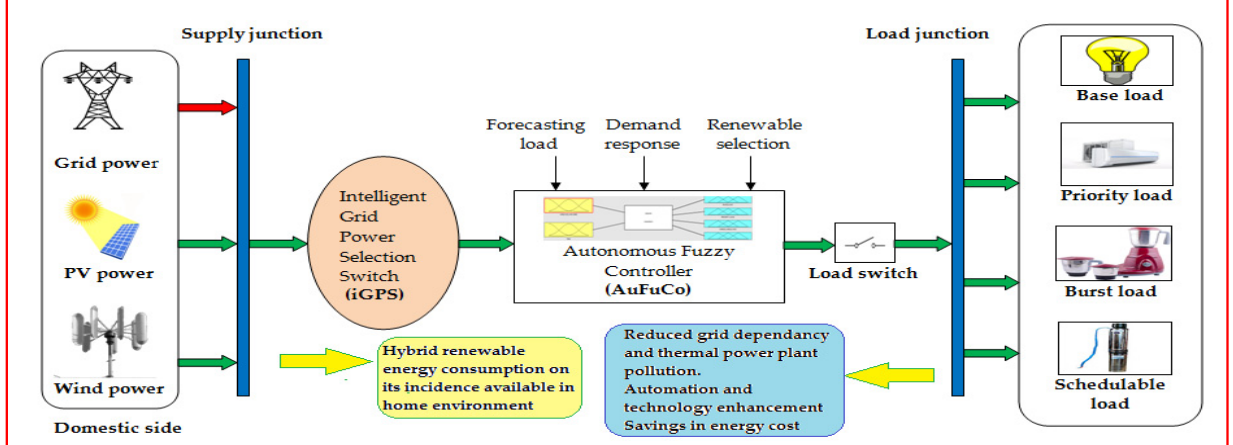
Figure 2. Schematic representation of the proposed work.